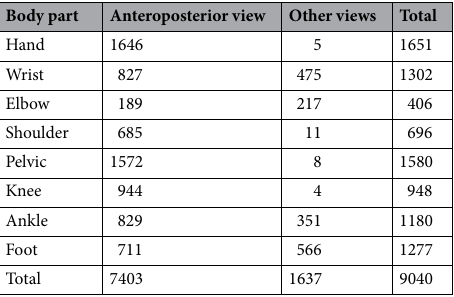
Table 5. Data distribution in body parts and different